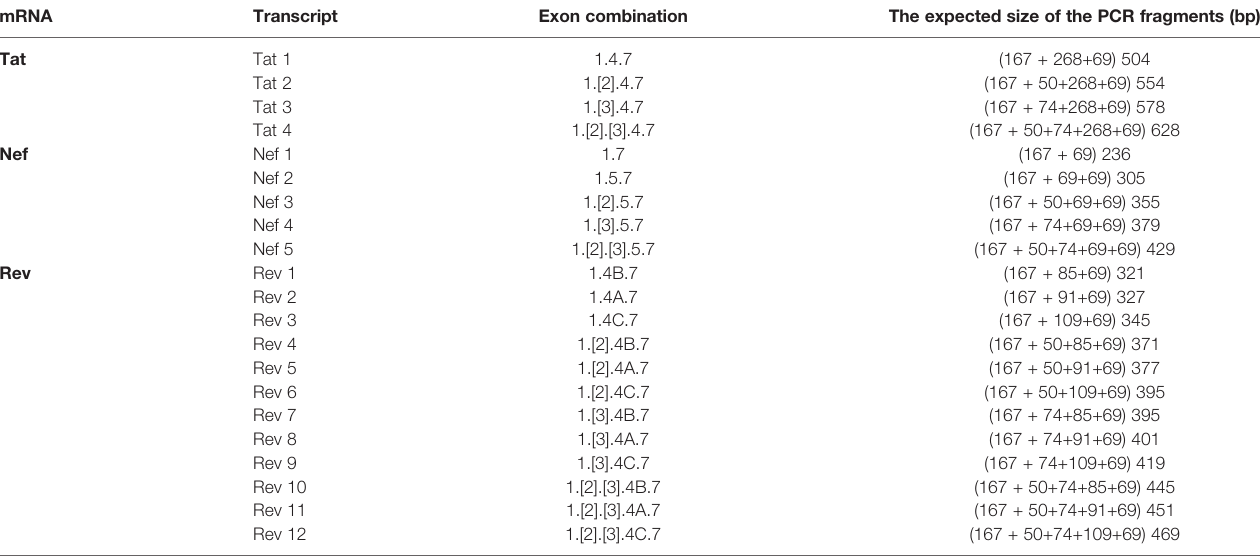
TABLE 2 | The expected size of various HIV-1 early viral transcripts in the TILDA. mRNA Transcript Exon combination The expected size of the PCR fragments (bp)